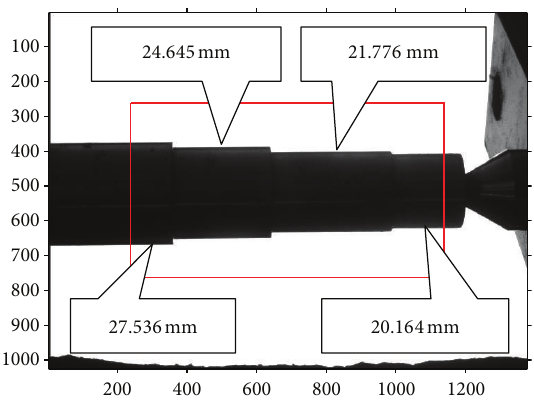
Figure 10: The imaging of two-segment shaft.